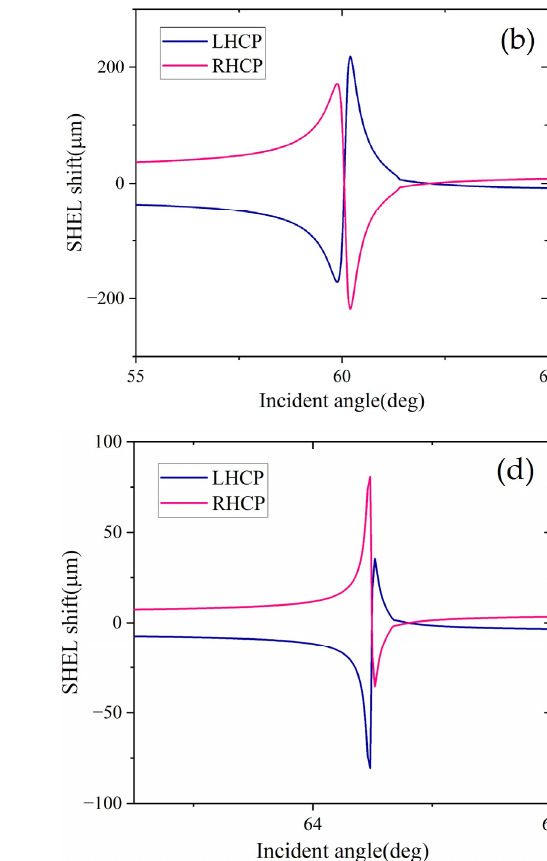
Figure 8. Variation of SHEL shift with incident light at different periods (n). ( a ) n = 1 ( b ) n = 3 ( c ) n = 7 ( d ) n = 11.